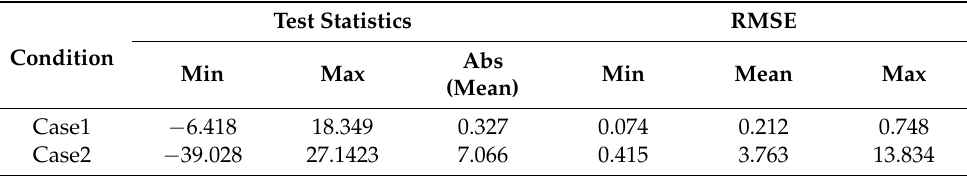
Table 1. statistics of CODM test statistics and RMSE (m). Table 2. statistics of CODM threshold